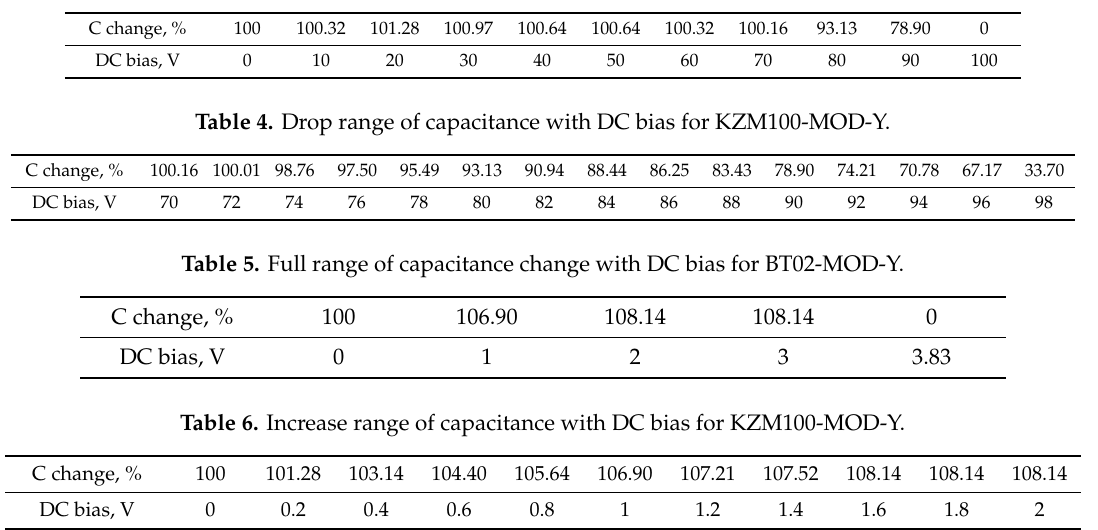
Table 3. Full range of capacitance change with DC bias for KZM100-MOD-Y.